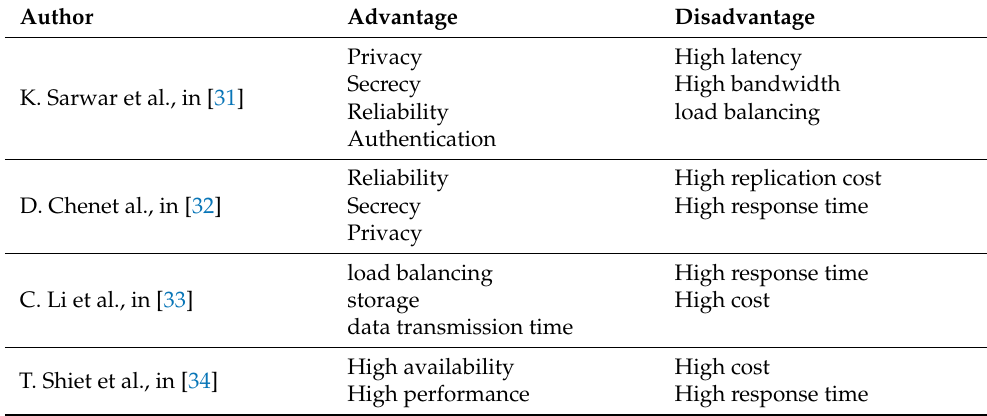
Table 1. Comparison of the reviewed select and placement data replication in the cloud